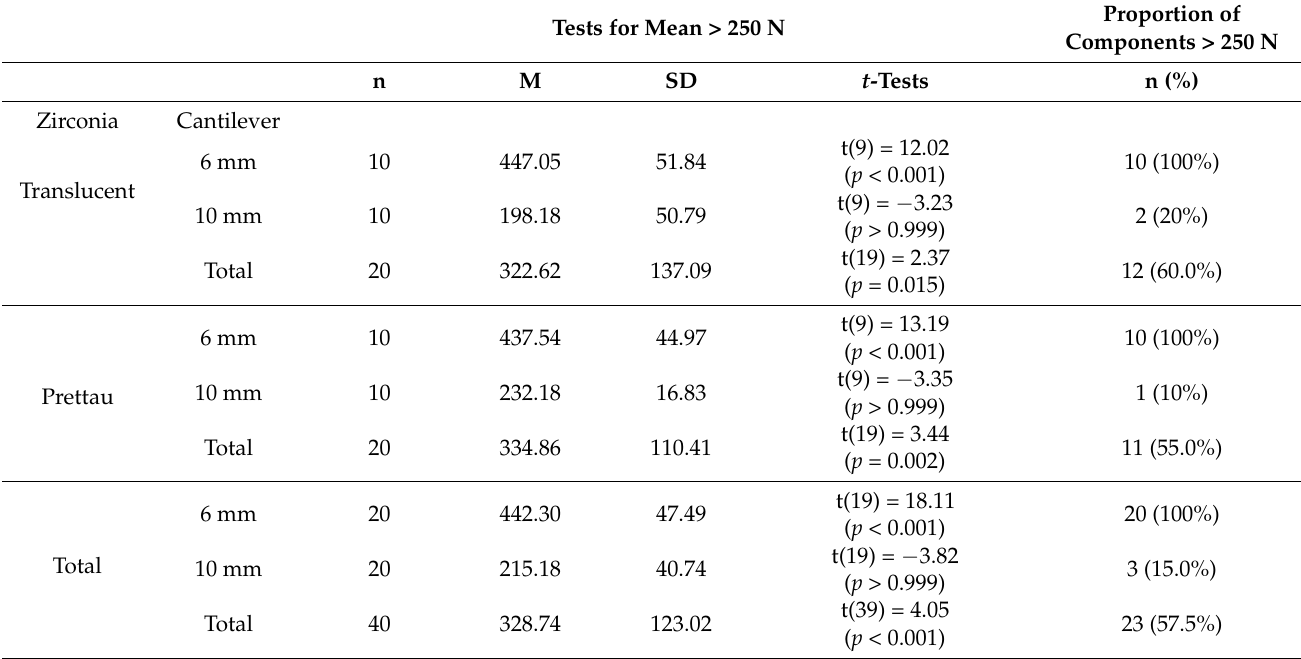
Table 5. Unilateral one-sample t -test s for assessing limits of force at break (standard) (N) . Tests for Mean > 250 N